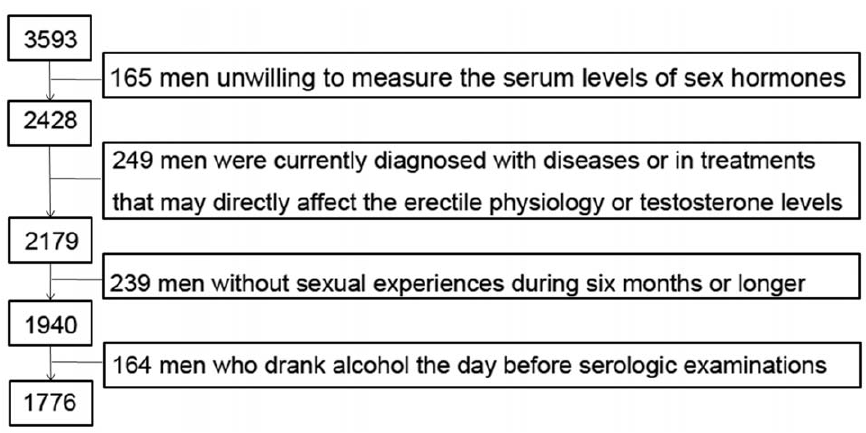
Figure 1. Flow chart of recruitment in the present study.